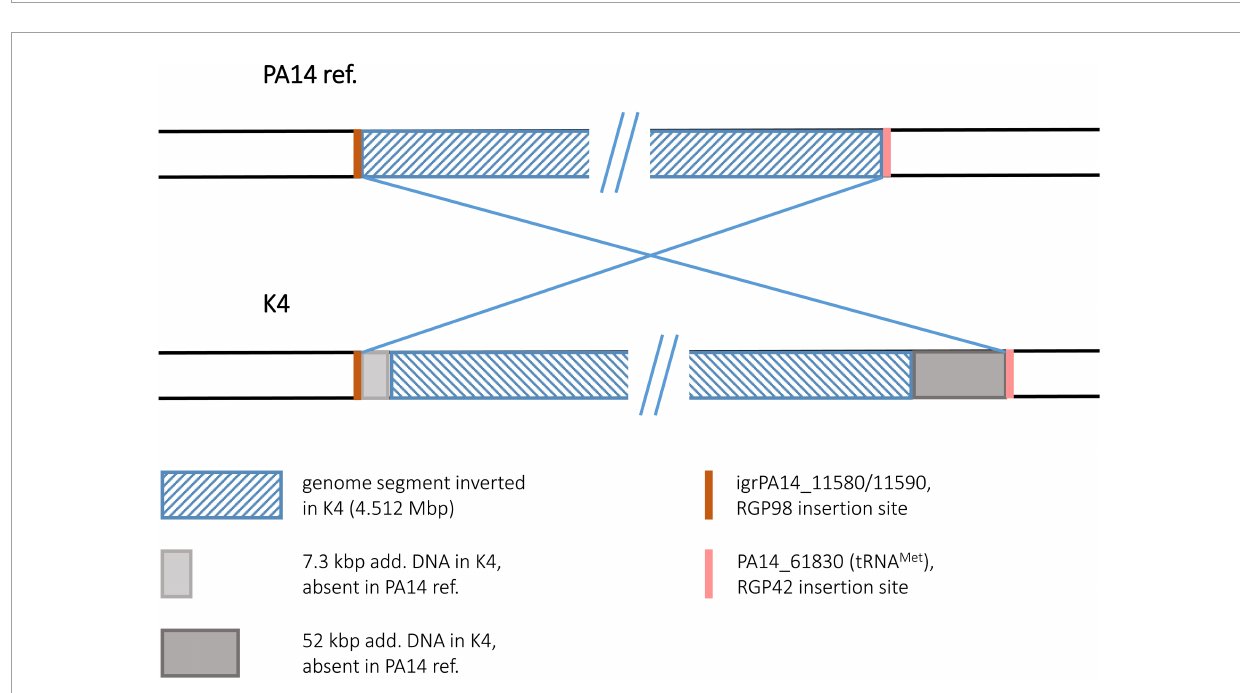
FIGURE9 Genomic inversion in strain K4. This figure illustrates the genomic inversion detected in strain K4. No duplicated sequences were identified at the breakpoints in K4, instead accessory DNA was found in both regions. The insertion sites for these accessory elements are indicated by orange and pink